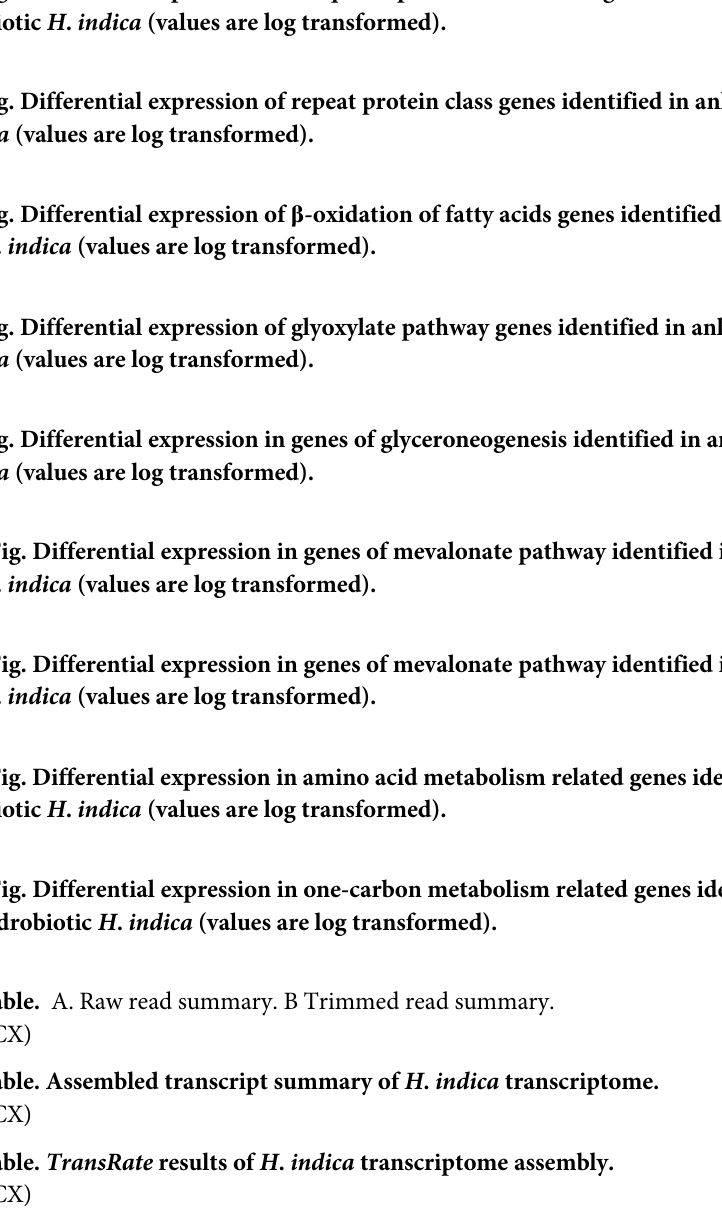
BUSCO results of H . indica transcriptome against Nematoda protein sets. (DOCX) S6 Table. Comparative assemble stats report of fresh + anhydrobiotic H . indica and Som- vanshi et . al ., (2016).